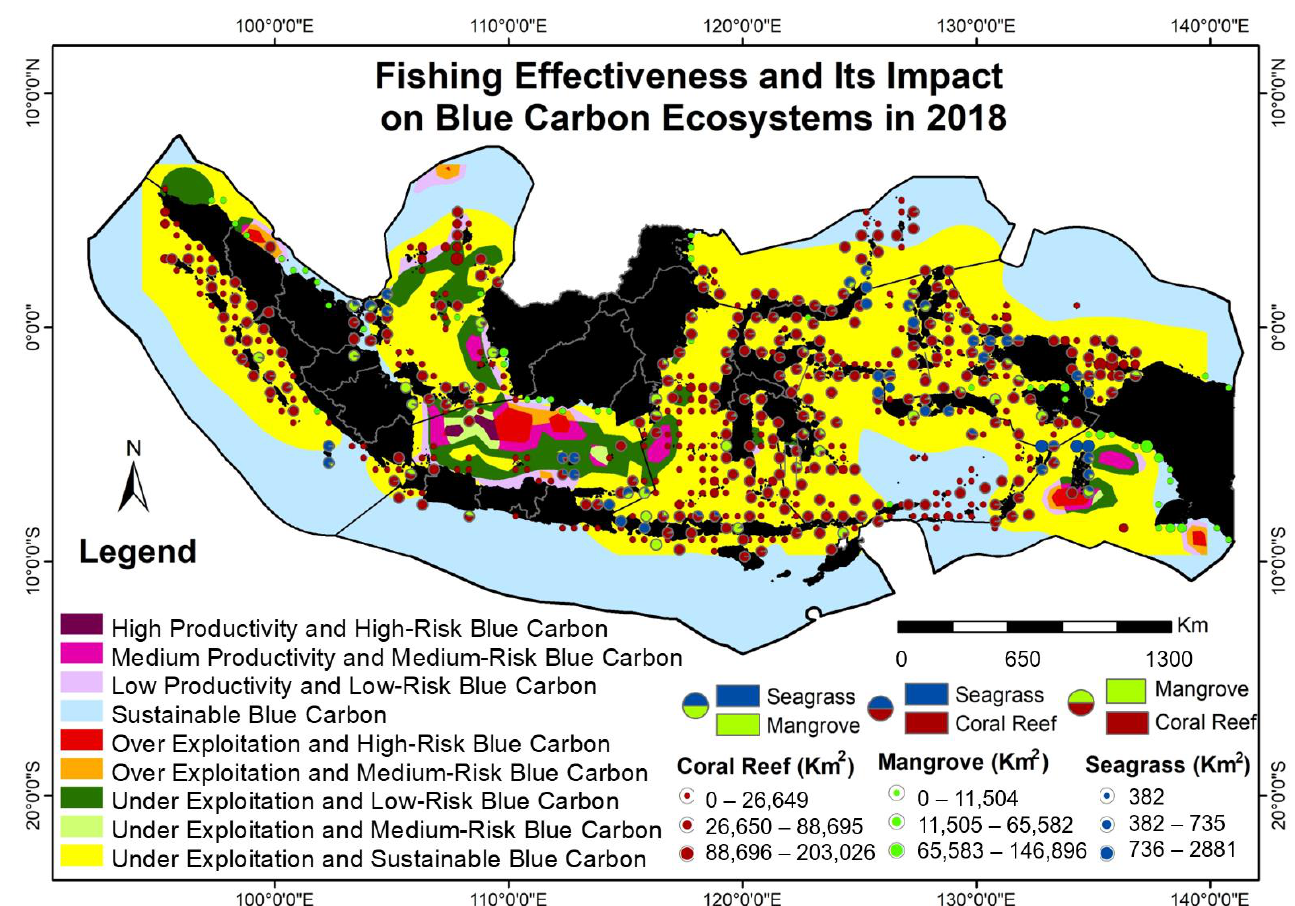
Figure 10. Spatial variation of fishing activity and blue carbon risk status in Indonesia.